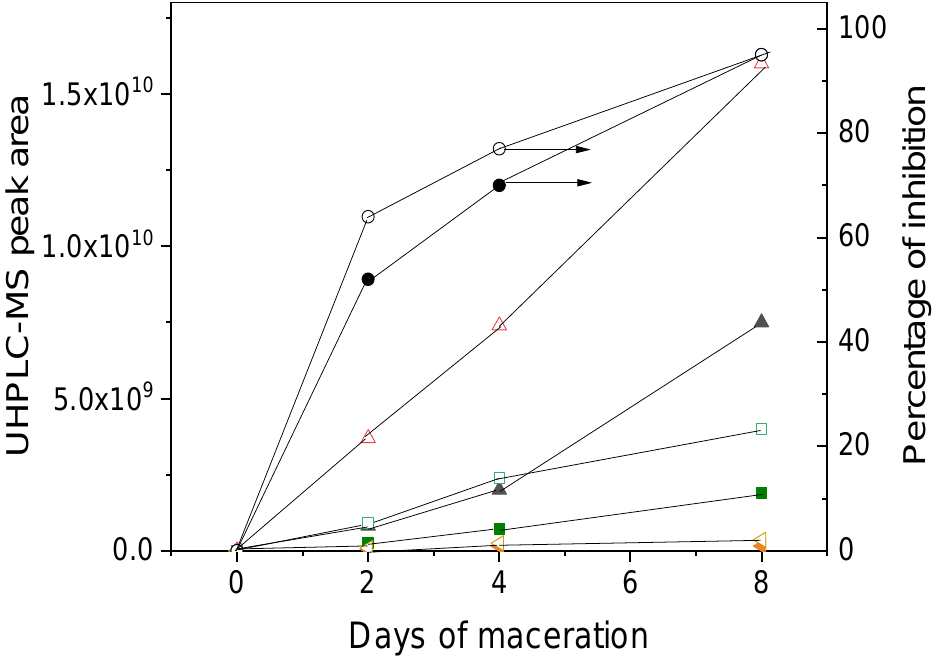
Figure 4. E ff ect of maceration time on UHPLC-MS peak area of quinic acid ( (cid:52) , (cid:78) ), coumaroyl quinic acid ( (cid:3) , (cid:4) ), and hydroxybenzoic acid ( (cid:47) , (cid:74) ) (left y -axis) and on percentage of inhibition of Lepidium sativum seed germination ( ◦ , • ) (right axis, arrows). Open symbols indicate macerates prepared with leaves collected from trees with solar exposure (L) and solid symbols indicate macerates prepared with leaves collected from trees facing north (S).